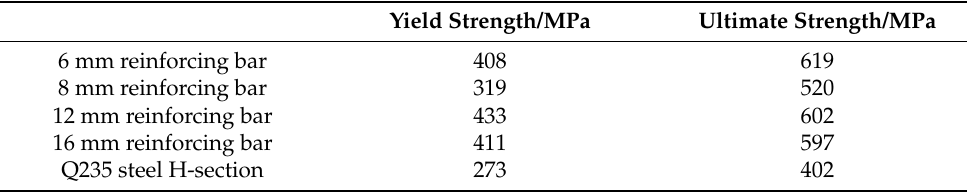
Table 2. Measured strength of reinforcing bar and steel plate. Yield